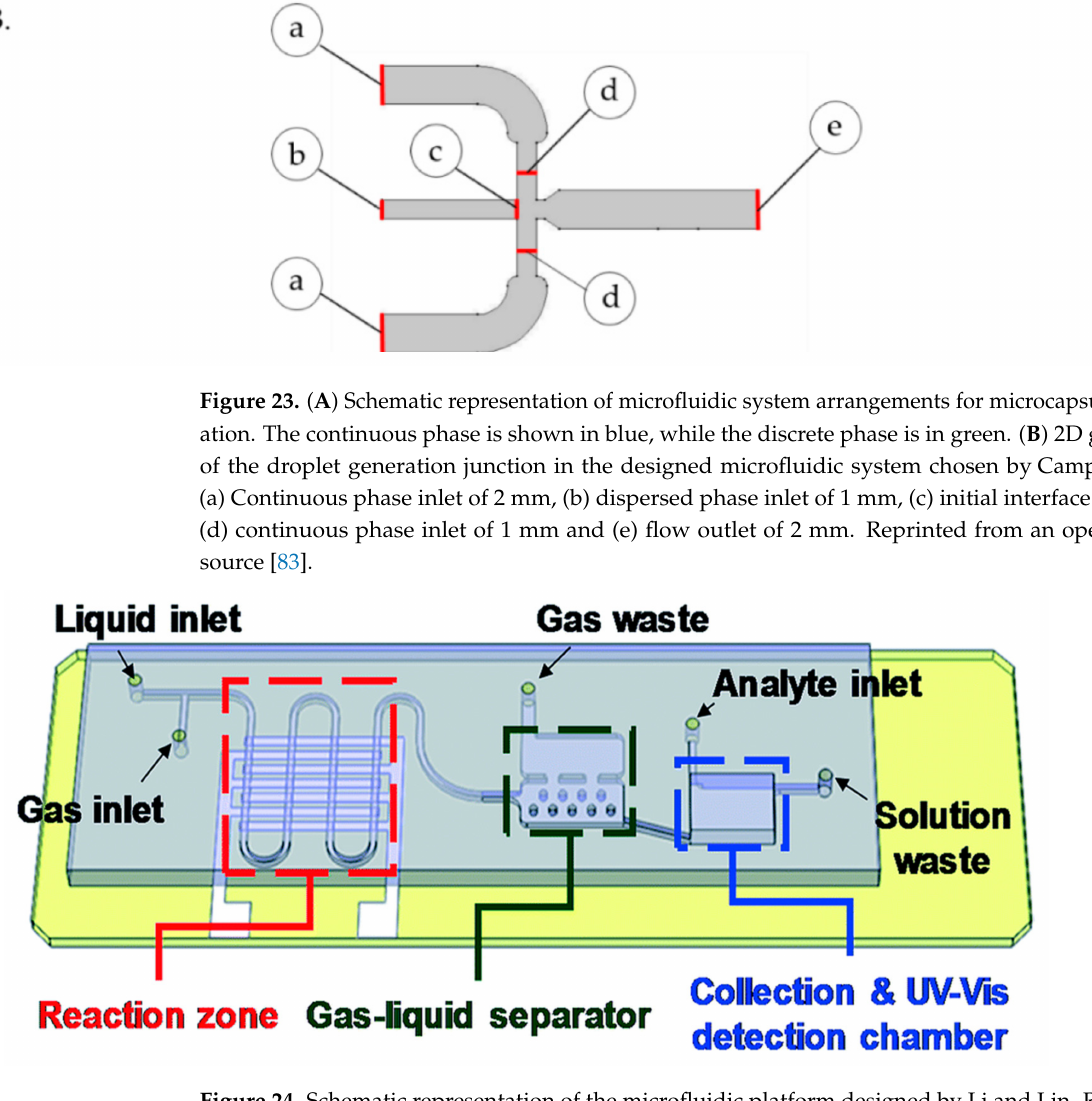
Figure 24. Schematic representation of the microfluidic platform designed by Li and Lin. Reprinted from an open-access source